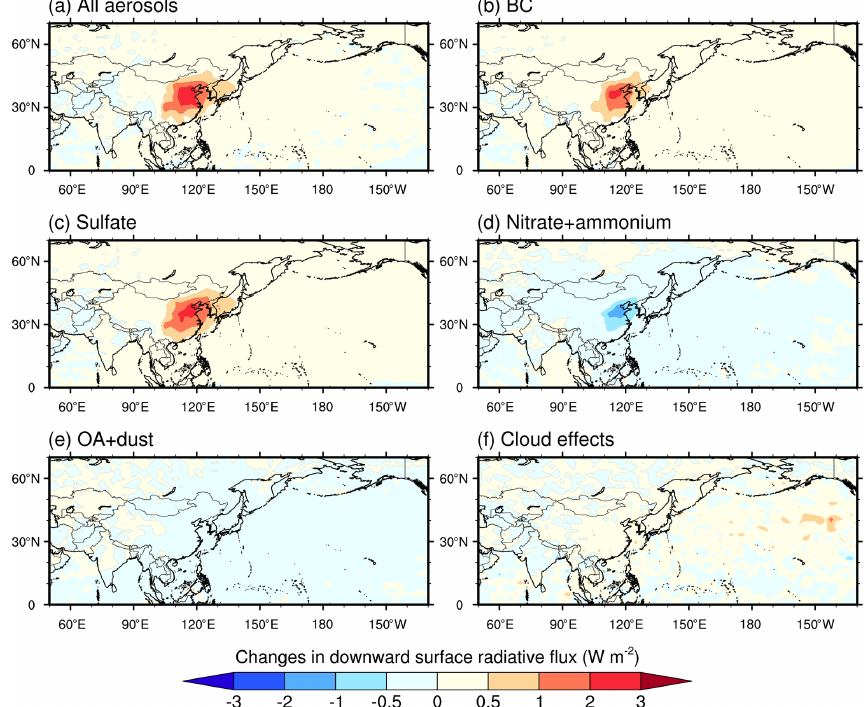
Figure 6. Map of the changes in downward shortwave radiation fluxes at the surface in China and outflow regions due to effects of all aerosols (a) , BC (b) , sulfate (c) , nitrate + ammonium (d) , OA + dust (e) , and clouds induced by aerosols (f) . The positive values indicate the surface brightening and the negative surface dimming. BC: black carbon; OA: organic aerosols.